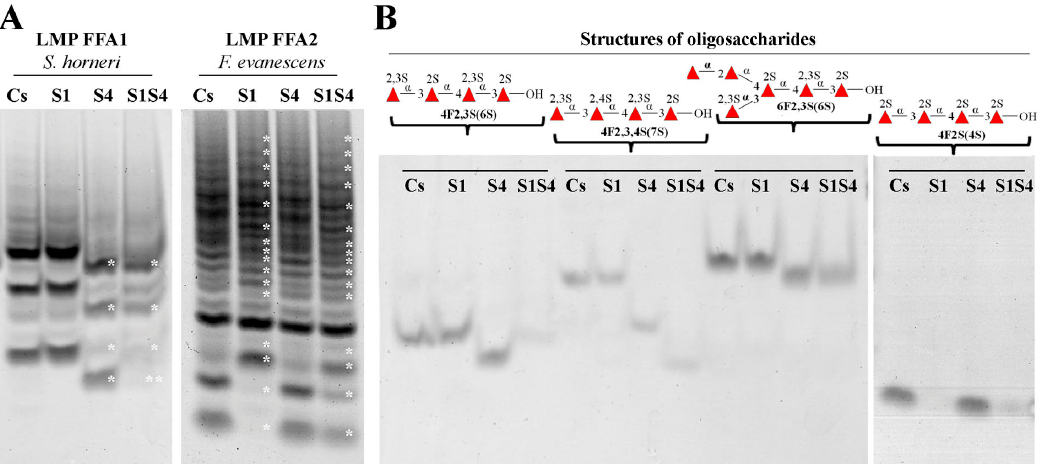
Figure 5. The electropherogram of the action by sulfatases SWF1 (S1), SWF4 (S4) and sulfatases mixture (S1S4) on a mixture of low molecular weight products (LMP) of S. horneri and F. evanescens fucoidans’ enzymatic hydrolysis by FFA1 and FFA2 ( A ) and oligosaccharides with defined structures ( B ). Structures of oligosaccharides used are schematically represented at the top of gels. *—visible changes under the influence of sulfatases on LMP fractions compared to substrate control (Cs); **—visible changes with the simultaneous action of sulfatases SWF1 and SWF4 (S1S4) compared to the action of SWF4 alone.